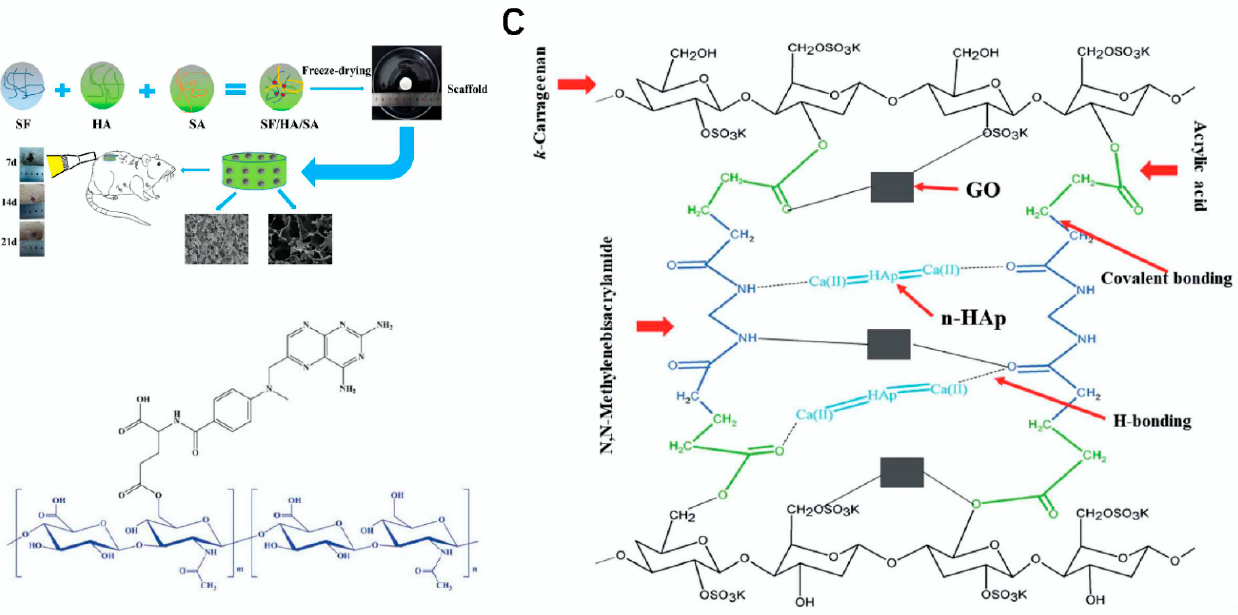
Figure 1. Construction and application of polysaccharide materials and composite scaffolders. ( A ) schematic diagram of the preparation of SF/HA/SA skin scaffolds and their application as wound dressings in a rat full-thickness burn model [21]. ( B ) schematic diagram of the HA–MTX composite [22]. ( C ) schematic diagram of the preparation of the carrageenan, graphene, acrylic acid, and hy- droxyapatite composite scaffold [23].